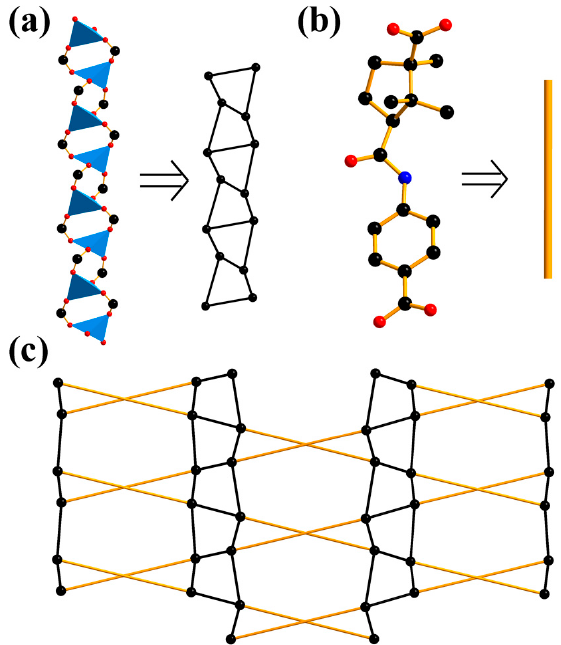
Figure 2. ( a ) Rod-shaped secondary building unit (SBU) with polyhedral Zn is simplified as a twisted ladder; ( b ) The ligand CTBA is considered as a stick. The hydrogen atoms have been omitted for clarity; ( c ) The net of the 2-dimensional layer framework.